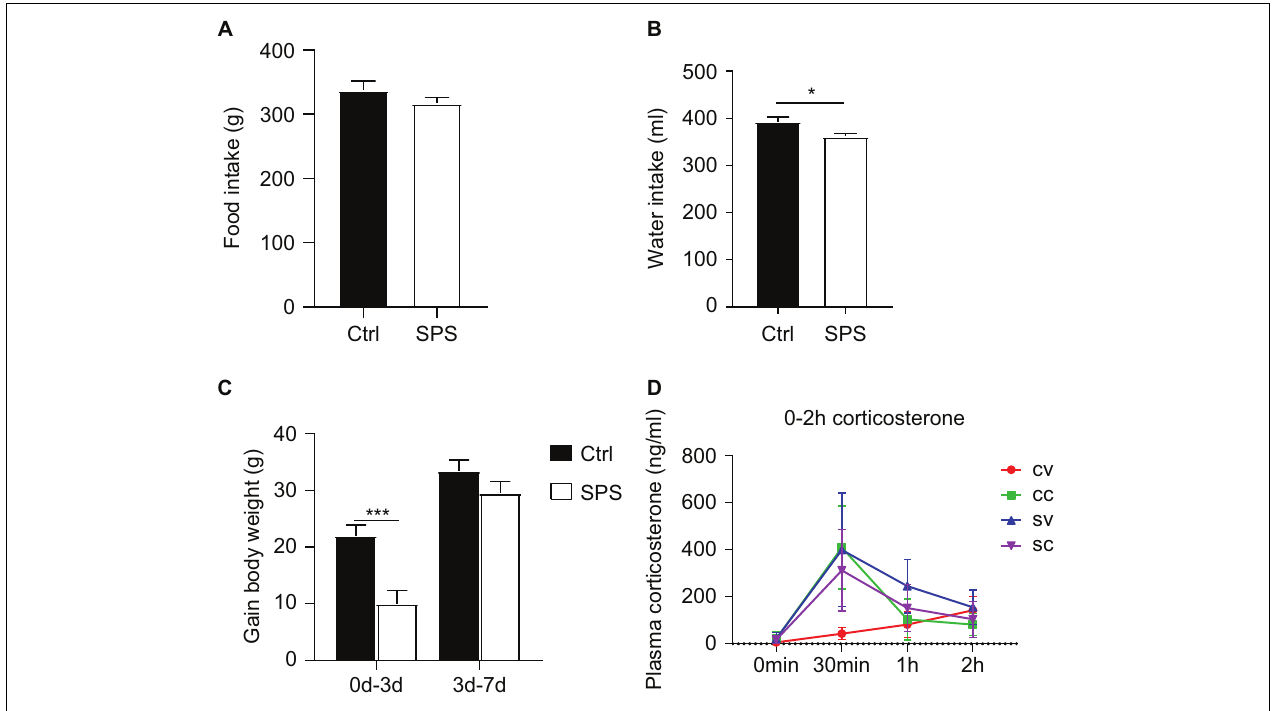
FIGURE 2 | Effects of SPS on food and water intake, body parameters, and corticosterone levels after injections. (A) Food consumption, (B) water consumption, (C) gain in body weight, and (D) corticosterone levels at 0 min, 0.5, 1, and 2 h after injection. CV, control+vehicle group; CC, control+CORT group; SV, SPS+vehicle group; SC, SPS+CORT group. * p < 0.05, *** p <